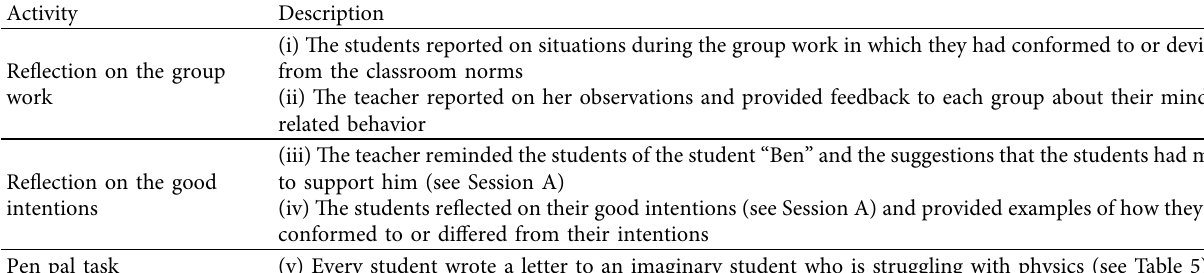
Table 4: Training Session